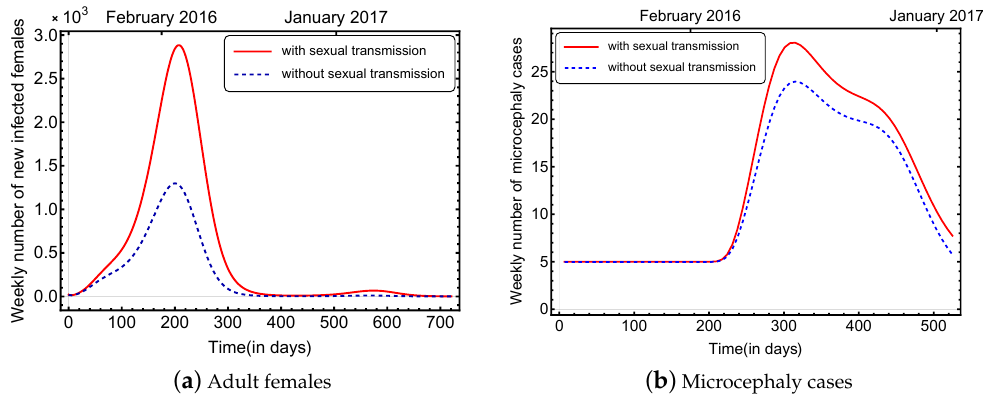
Figure 6. Number of symptomatically infected adult females and estimated number of symptomati- cally infected adult females without sexual transmission in ( a ), and in ( b ) the number of microcephaly cases and estimated number of microcephaly cases without sexual